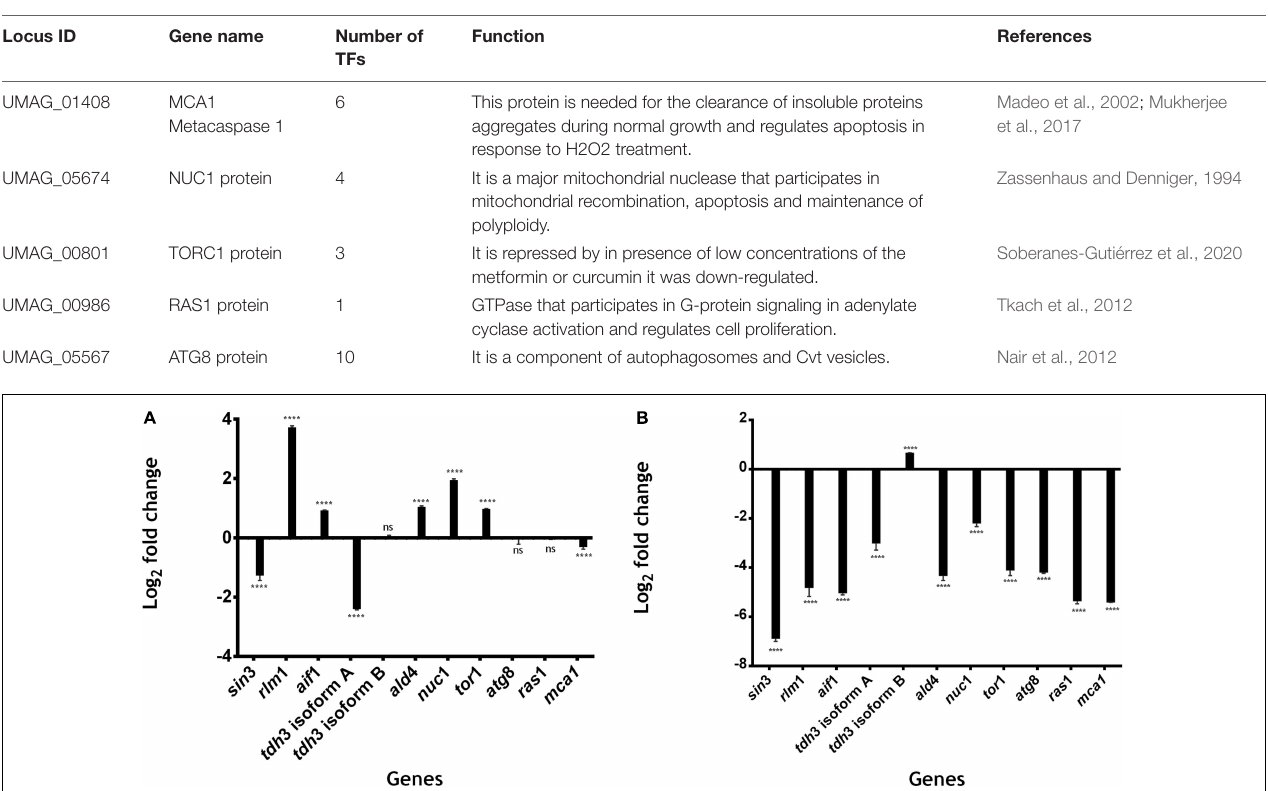
FIGURE 5 | Gene expression related to cell death in U. maydis. 1 × 10 6 cells · ml − 1 were incubated in MC medium for 24 h (exponential phase), 48 h (stationary phase begins), and 72 h (aged yeast cells) and the expression of genes related to cell death was measured by qRT-PCR. (A) Log 2 fold change in the expression of genes of U. maydis at 48 h of growth. (B) Log 2 fold change in the expression of genes of U. maydis at 72 h of growth. The actin gene was used as an endogenous control, and the relative expression ratio of target genes was calculated by the 2 − (cid:49)(cid:49) CT method. All results are from three independent experiments. The values presented are the means ± SD for each group, ns is P -value > 0.05 and ***is P -value < 0.0001 vs. Control.